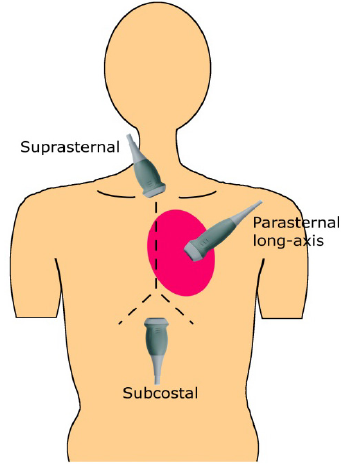
Figure 2: Positioning of the ultrasound transducer for the three views.